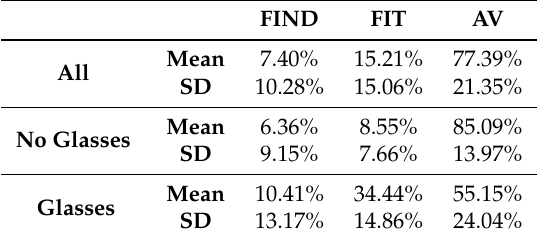
Table 3. Average availability of video-based emotion